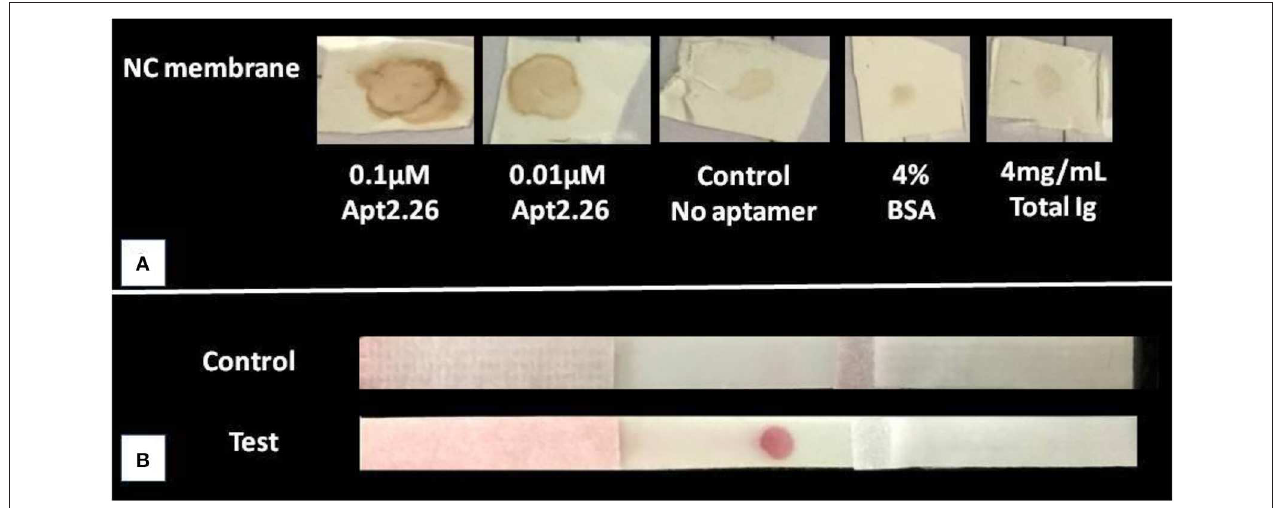
FIGURE 5 | Binding study of CA125 with aptamer 2.26 using (A) Dot ELASA where CA125 was immobilized on nitrocellulose membrane, blocked, and then incubated with biotinylated apt2.26 followed by incubation with streptavidin-HRP. DAB/H 2 O 2 was used as a peroxidase substrate resulting in a brown colored product. (B) NALFA ( N = 4 for both assays) where 10 µ M aptamer was immobilized on NC laminate, and AuNPs- CA125 conjugate was applied on a reservoir matrix. The assay was run using PBS containing BSA and Tween-20.